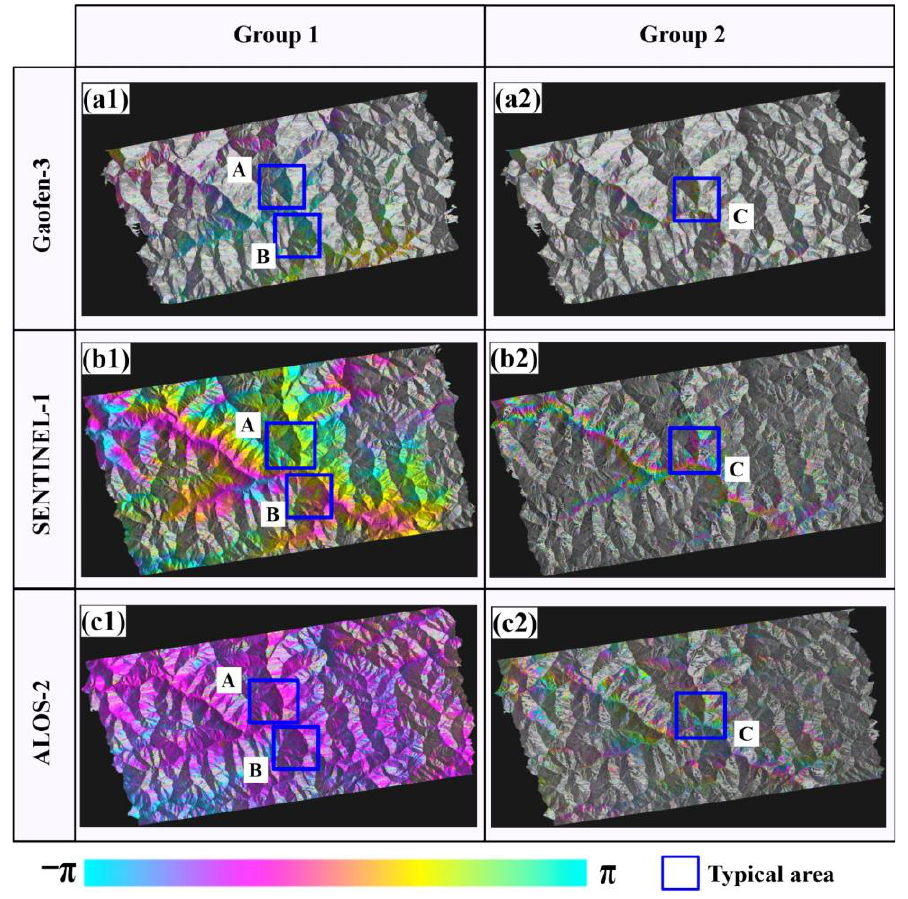
Figure 4. Comparison of the interferograms: ( a1 , a2 ) are the Gaofen-3 satellite ’s interference pairs